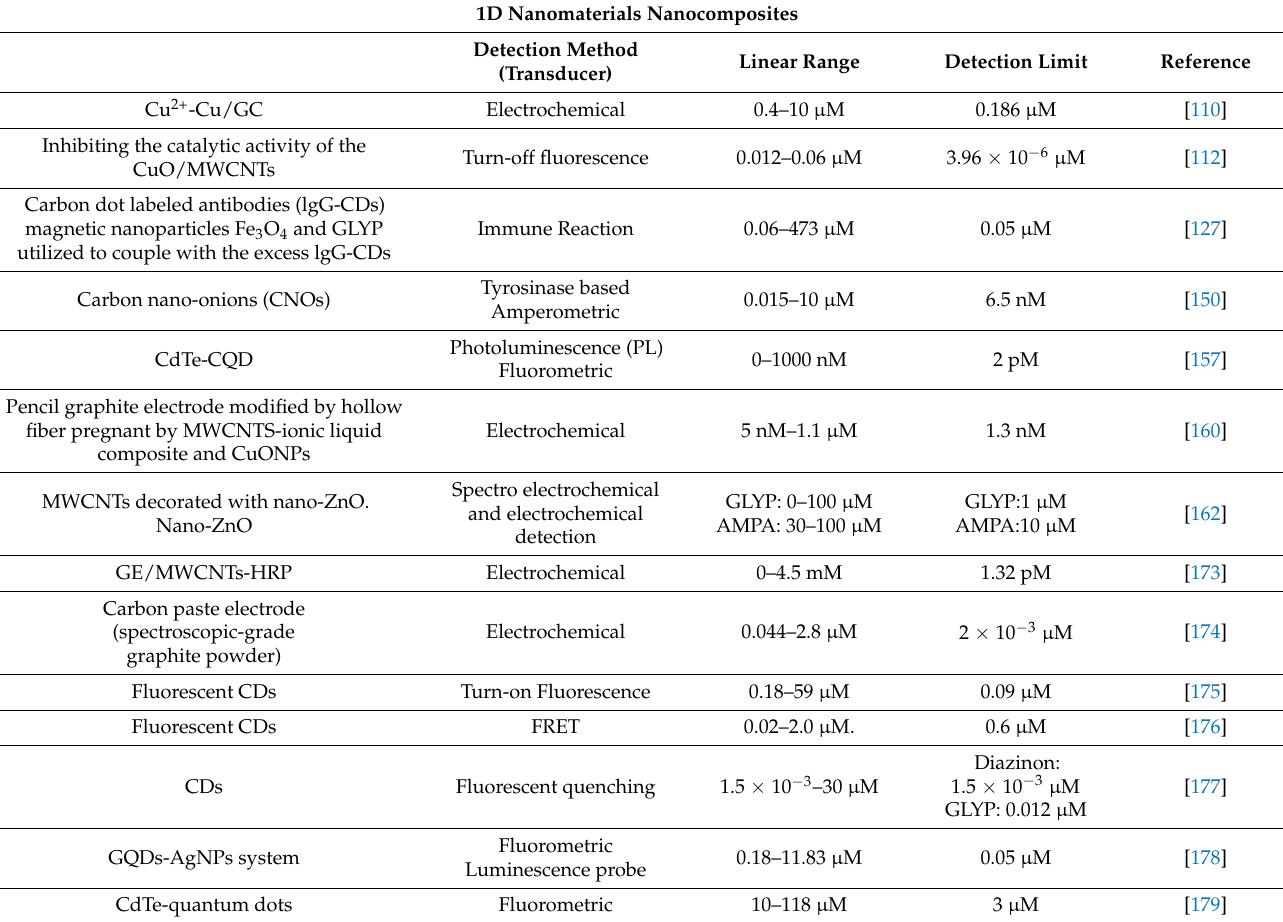
Table 3. The 1D, 2D, and 3D nanomaterials used in sensor development for detection of GLYP. 1D Nanomaterials